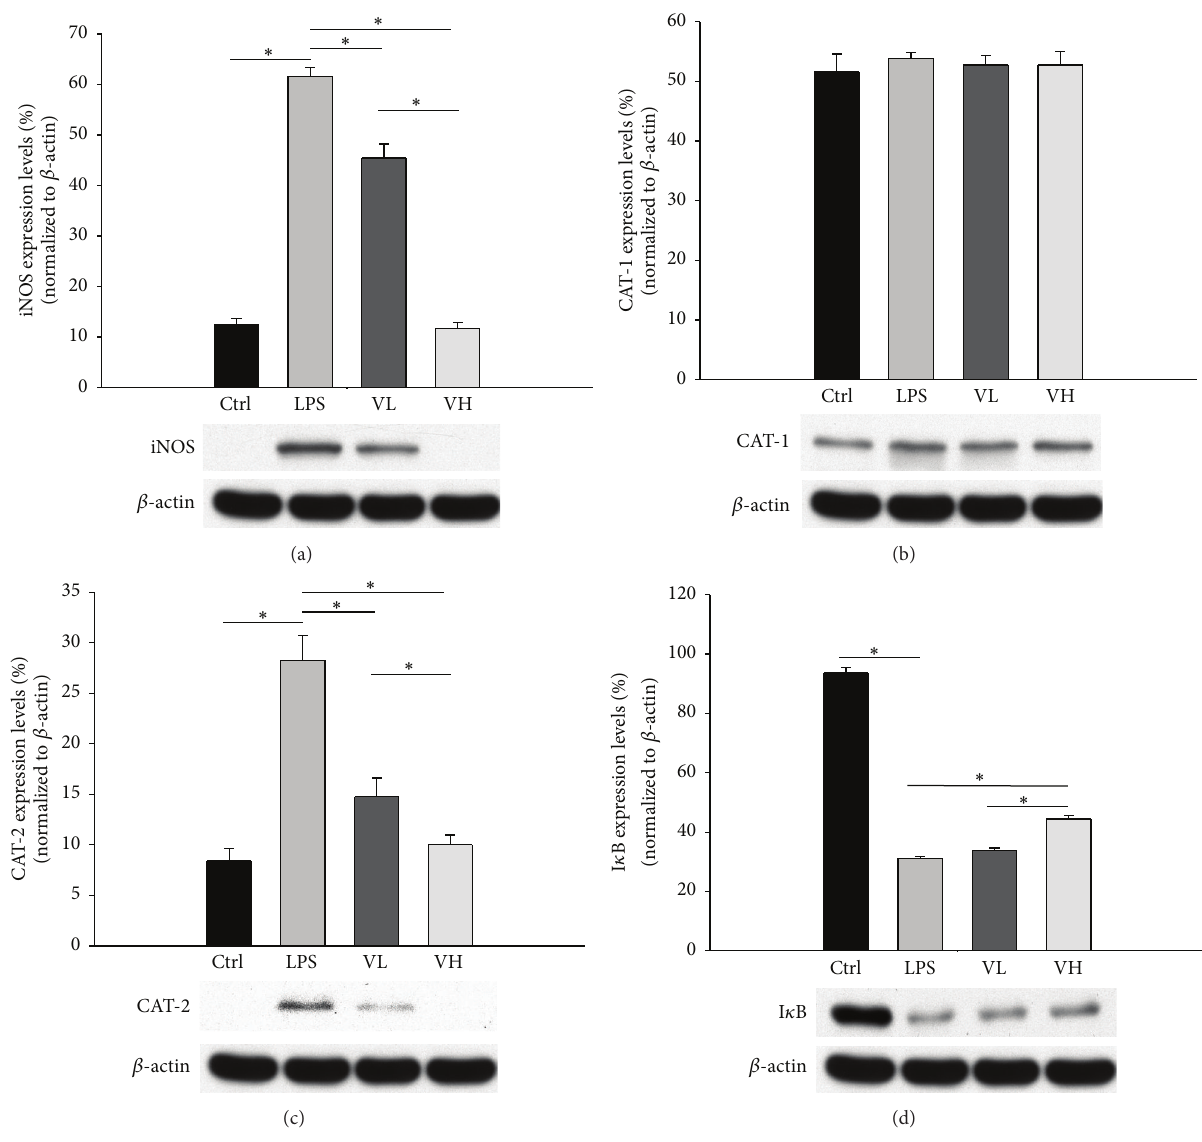
Figure5:ExpressionofiNOS,CAT-1,andCAT-2proteinsintheICBsasassessedbywesternblotting.Theproteinswereisolatedundercontrol conditions (Ctrl), from rats injected with LPS (LPS), and from rats pretreated with low-dose bortezomib (VL) or high-dose bortezomib (VH). LPS induced the expression of iNOS and CAT-2 proteins in the ICBs of EIU rats. Pretreatment with bortezomib decreased their expression (a and c). There were no significant differences in CAT-1 protein levels among the four groups (b). As compared with the control group, the protein levels of I 𝜅 B decreased in the LPS group and increased in the bortezomib treatment groups. The symbol “ ∗ ” indicates statistical